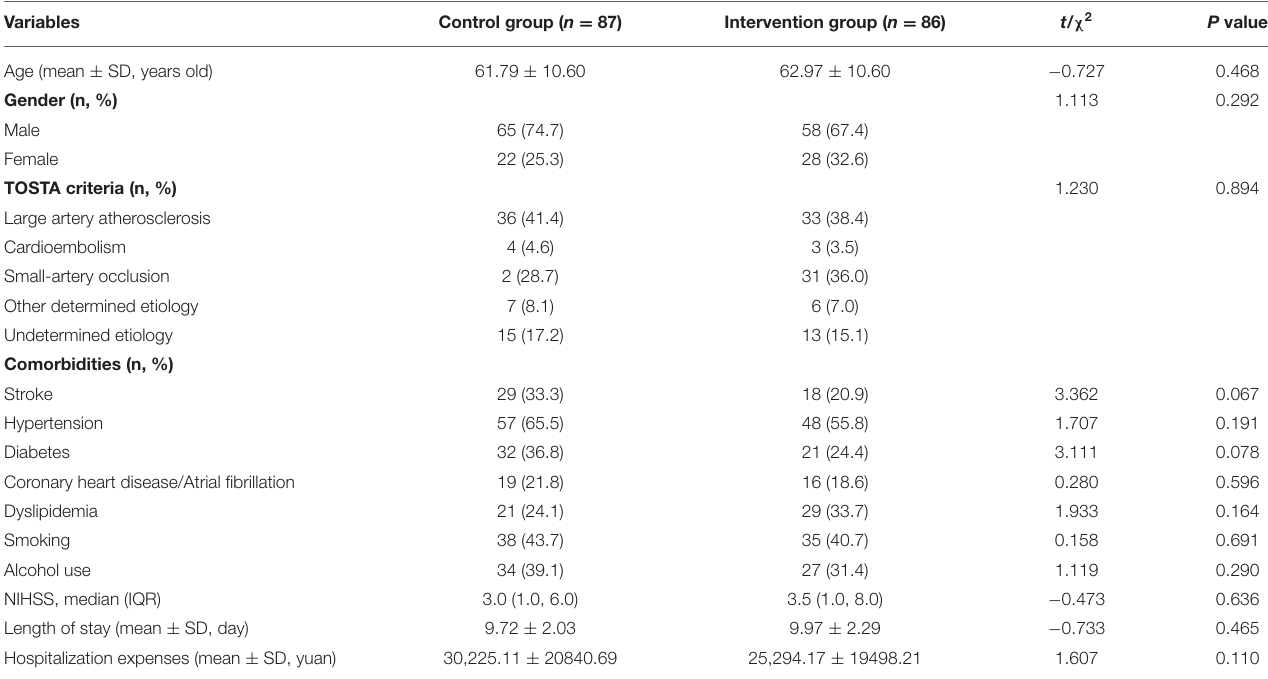
TABLE 1 | Baseline characteristics between control and intervention